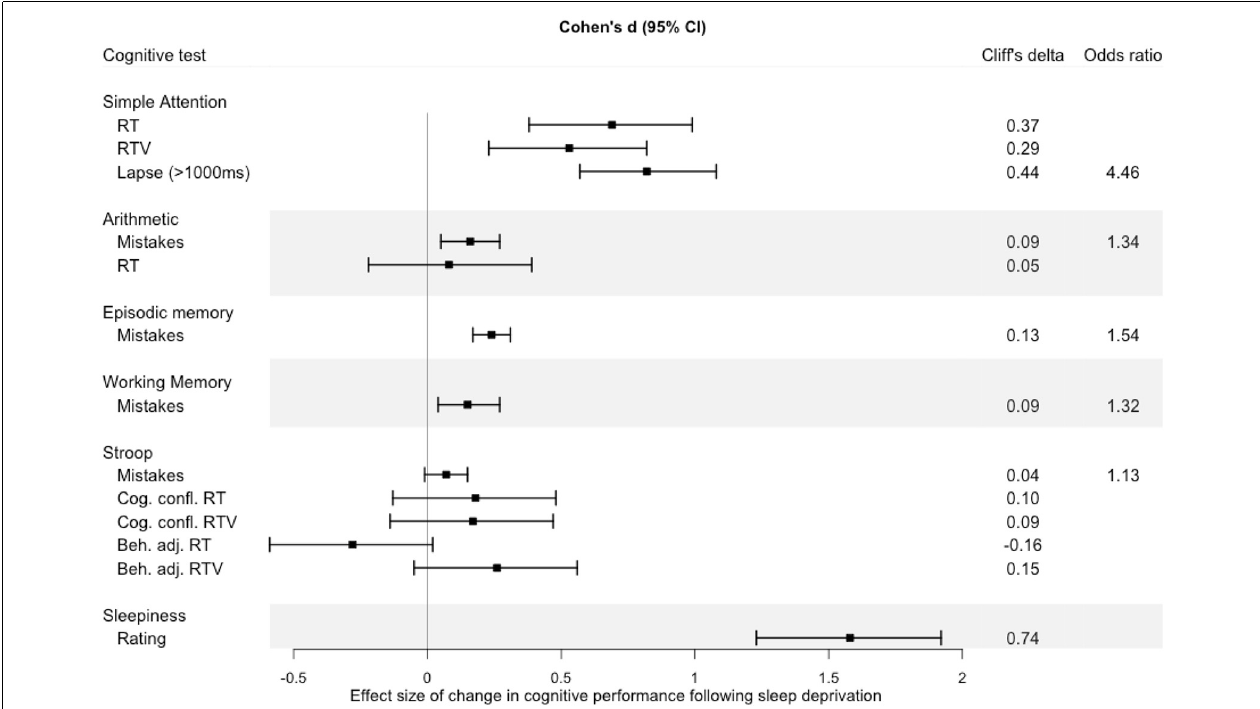
FIGURE 7 | Effect size of change in performance from baseline (22:30 h) to performance after sleep deprivation (mean of performance at 08:00 h, 12:30 h, 16:30 h). Error bars represent 95% confidence intervals around the Cohen’s d value. The effect size estimates were calculated using the compute.es (Del Re, 2013) package in R, and plotted using the forestplot (Max and Lumley, 2020)